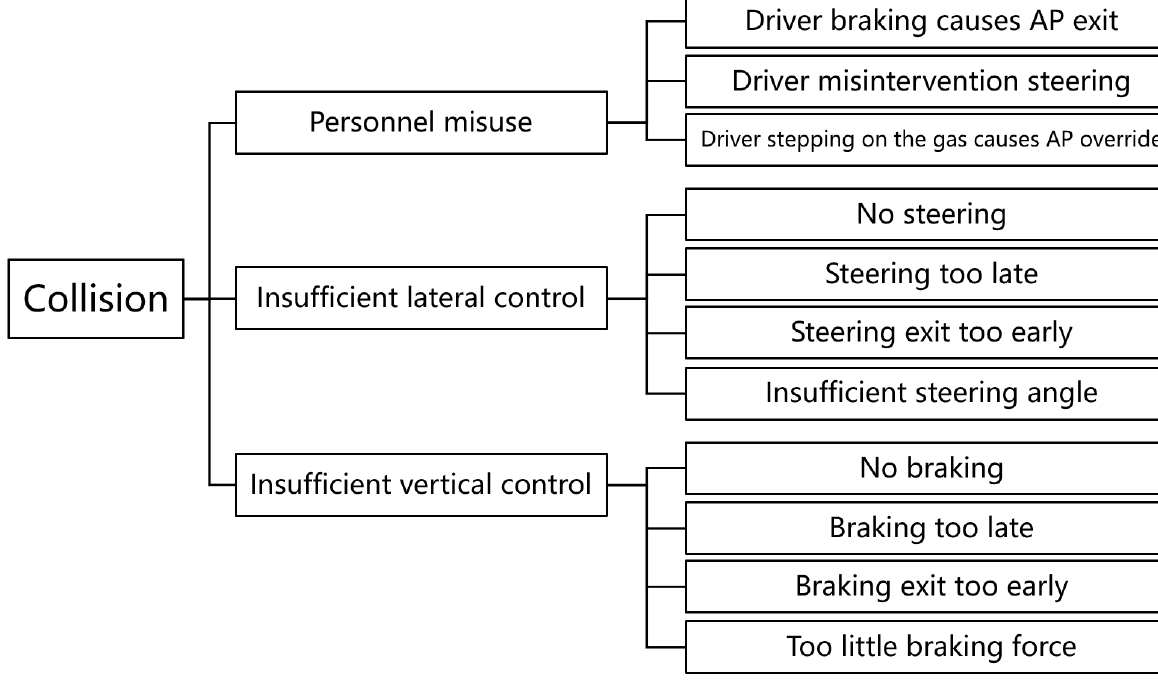
Figure 6. Vehicle-level hazards in the cut-in functional